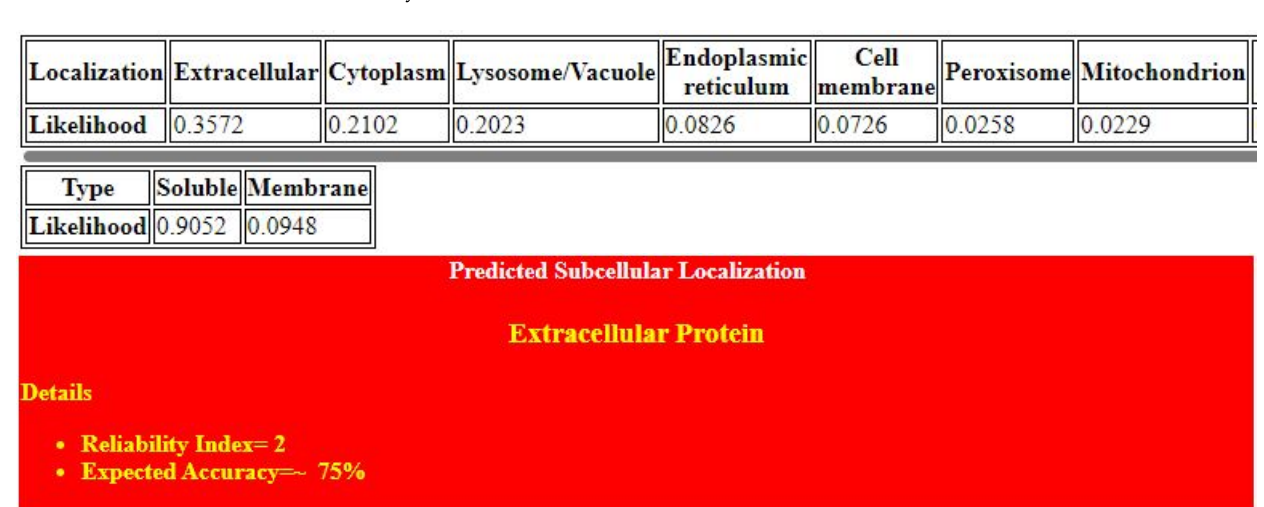
Figure 1. Domain architecture of α -glucosidase with three main domains and a glycoside hydrolase family.